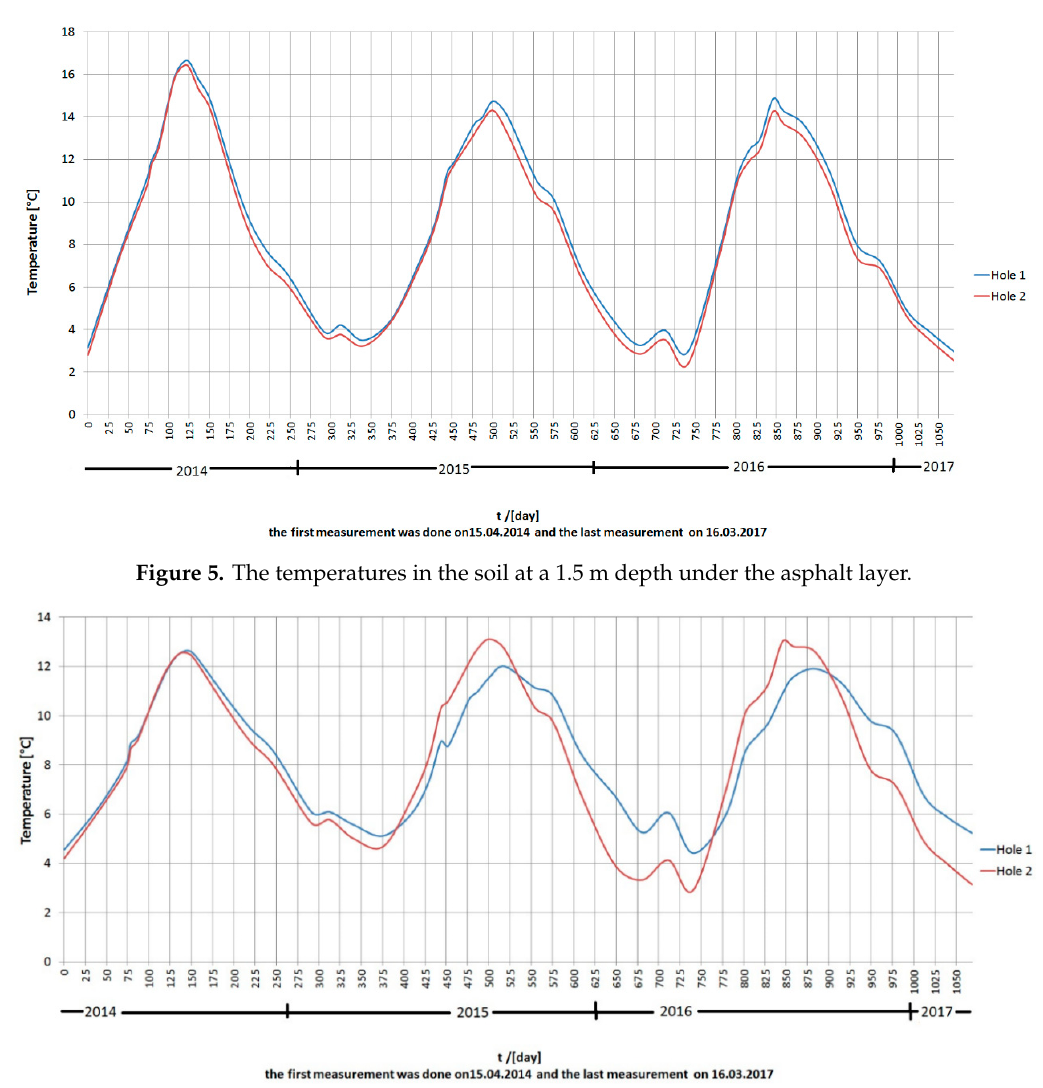
Figure 6. Temperatures in the soil at a 3.0 m depth under the asphalt layer.